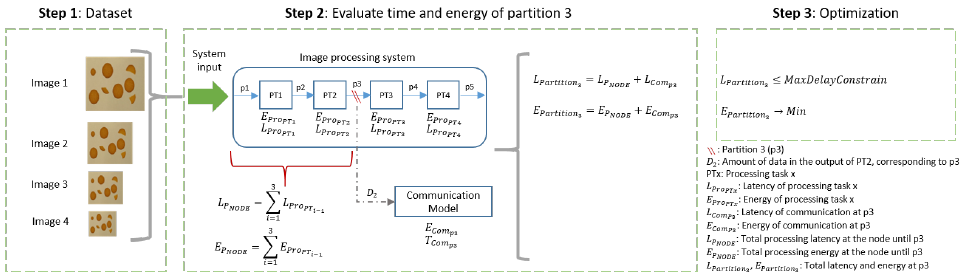
Figure 15. Example of partitioning analysis. In this example, we evaluate partition 3 with respect to a set of four images which vary in size. The partition analysis must be done on all possible partition points of the